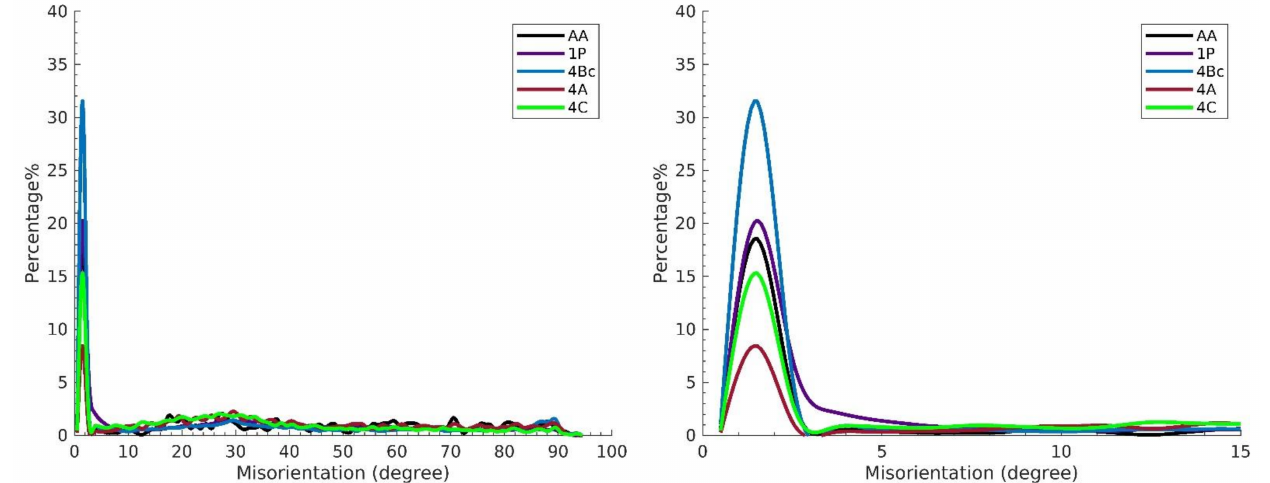
Figure 5. Misorientation angle distribution histograms obtained from the EBSD data for ZK 30 alloy before and after ECAP